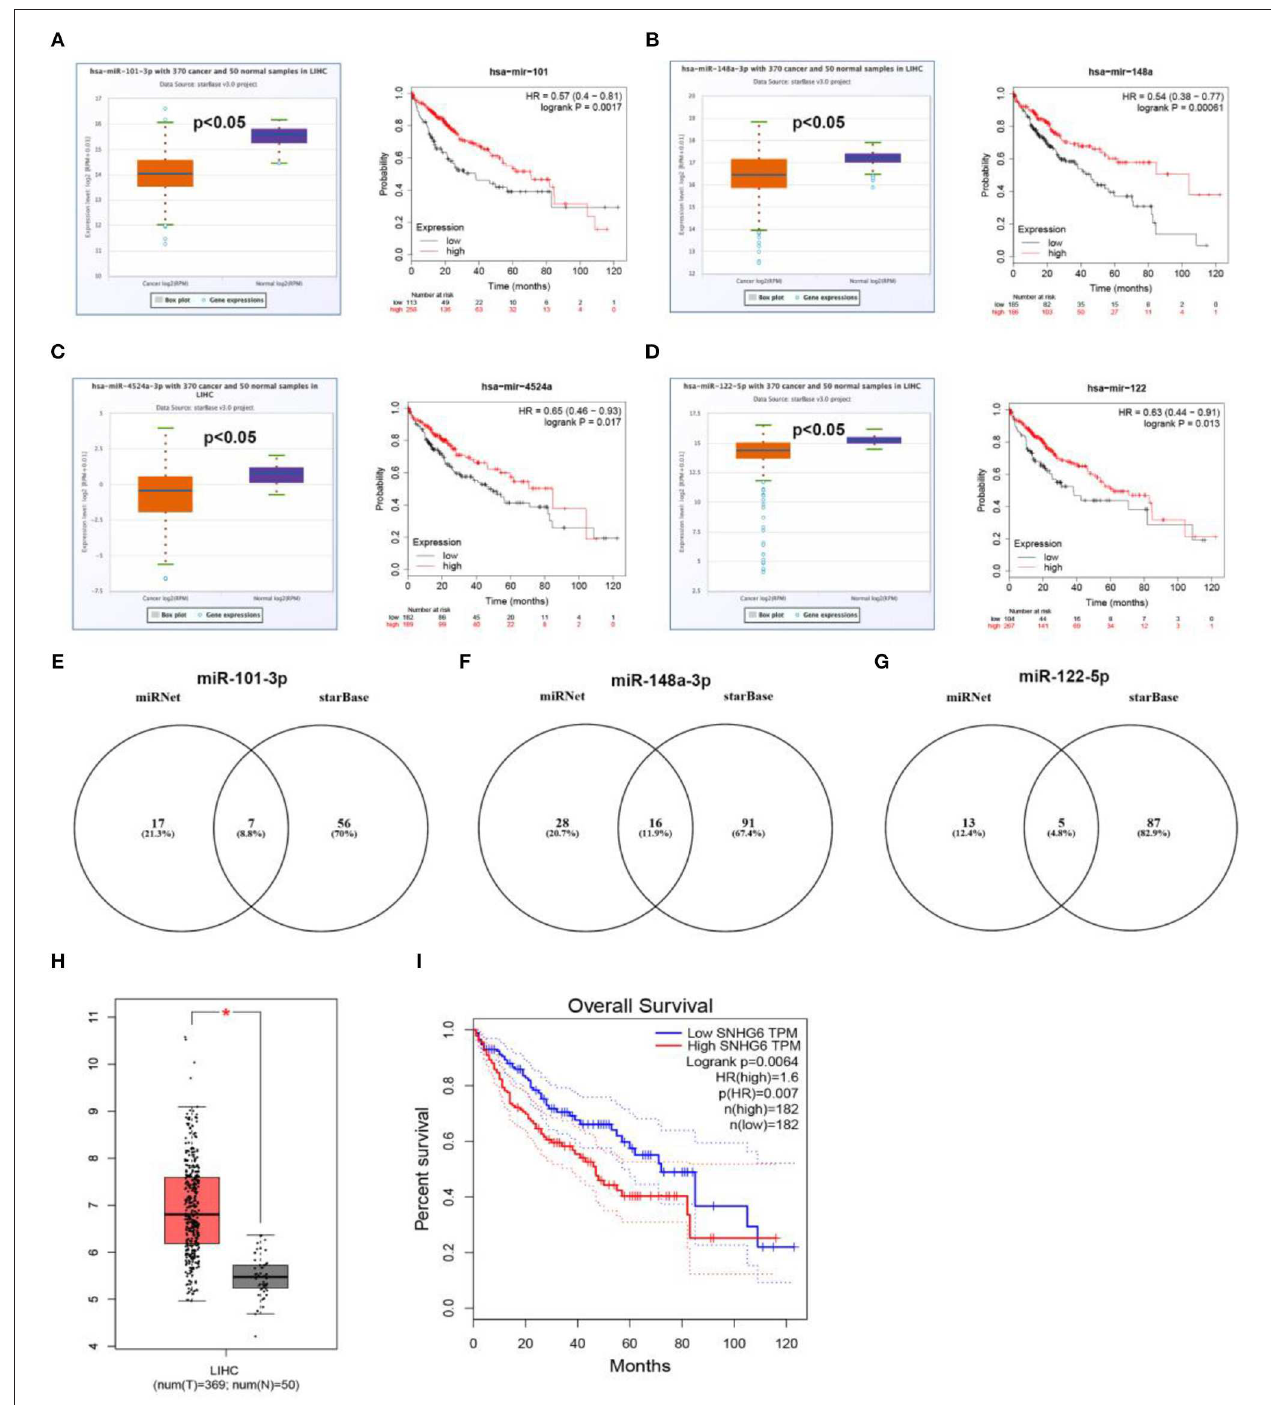
FIGURE 8 | Prediction and validation of upstream miRNAs and lncRNAs of six “known” genes. Expression and prognostic value of hsa-mir-101-3p (A) , hsa-mir-148a-3p (B) , hsa-mir-4524a-3p (C) , hsa-mir-122-5p (D) . Potential lncRNAs of hsa-mir-101-3p (E) , hsa-mir-148a-3p (F) , hsa-mir-122-5p (G) , predicted by miRNet and starBase. (H) Expression of SNHG6 in hepatocellular carcinoma analyzed by GEPIA. (I) The prognostic value of SNHG6 in hepatocellular carcinoma assessed by GEPIA database.